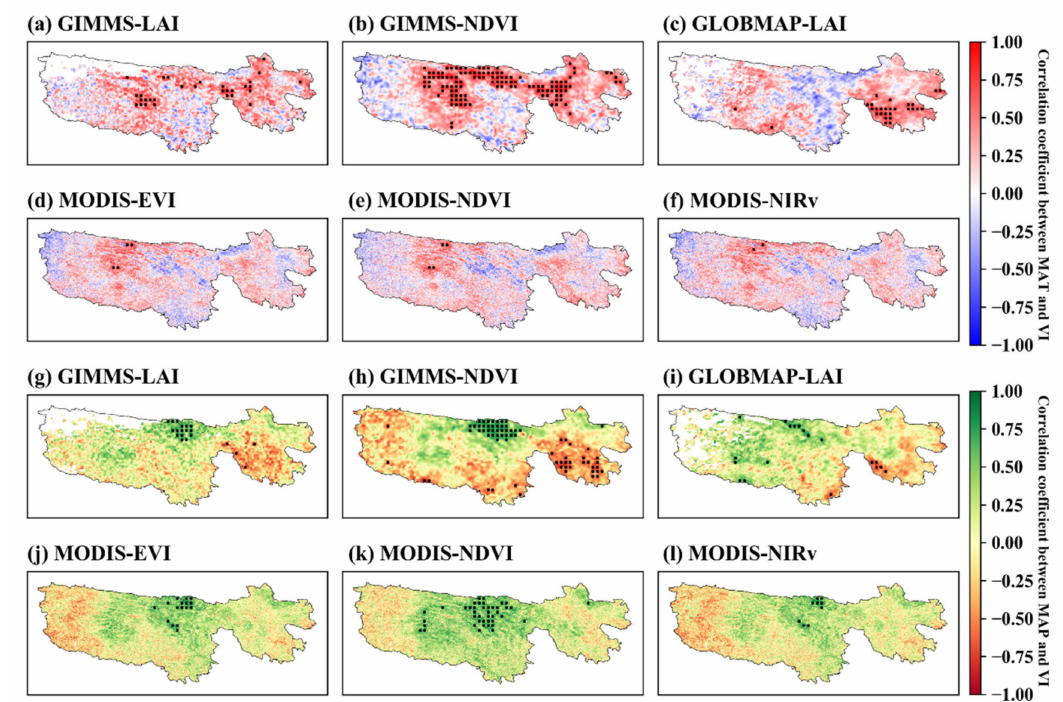
Figure A2. Spatial pattern of the correlations between VI (Vegetation Index) and MAT (Mean Annual Temperature) ( a – f ) and MAP (Mean Annual Precipitation) ( g – l ) from 2001 to 2016. The regions with black dots indicate that the trend is statistically significant at the 0.05